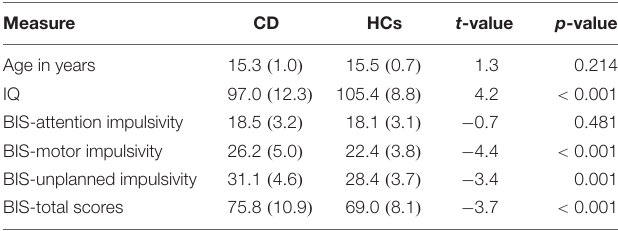
TABLE 1 | Demographic and clinical characteristics of the conduct disorder (CD) group and the healthy controls (HCs)